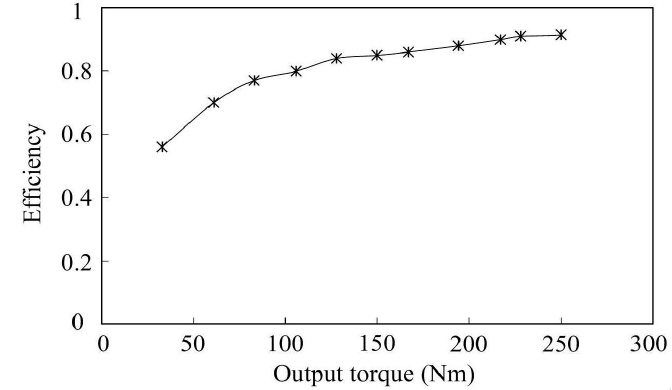
Figure 14. Measured efficiency of prototype